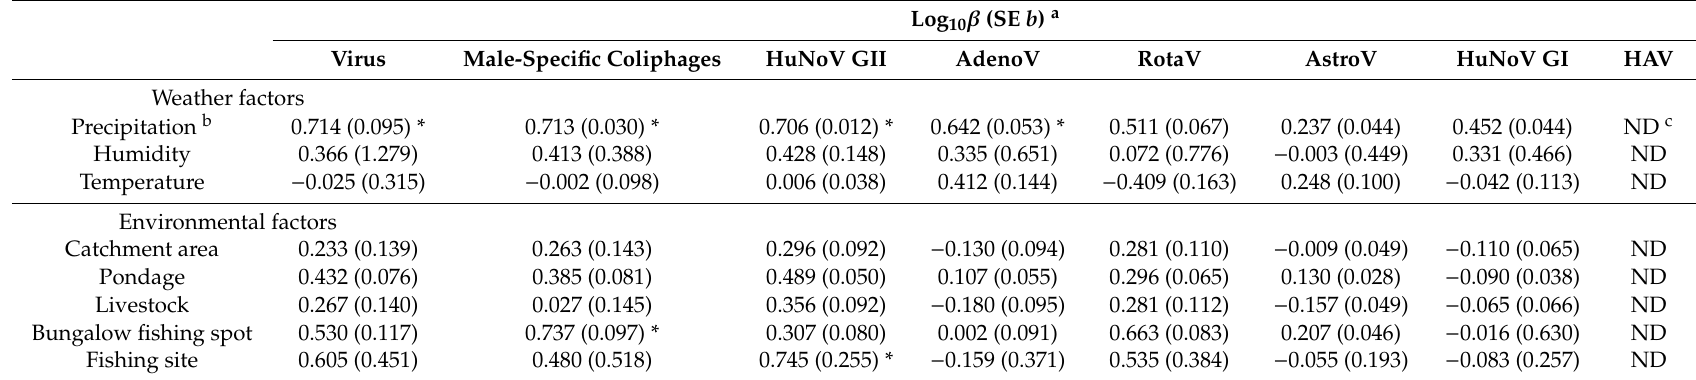
Table 5. Results of linear regression analysis between the number of positive samples for viruses / male-specific coliphages and weather / environmental